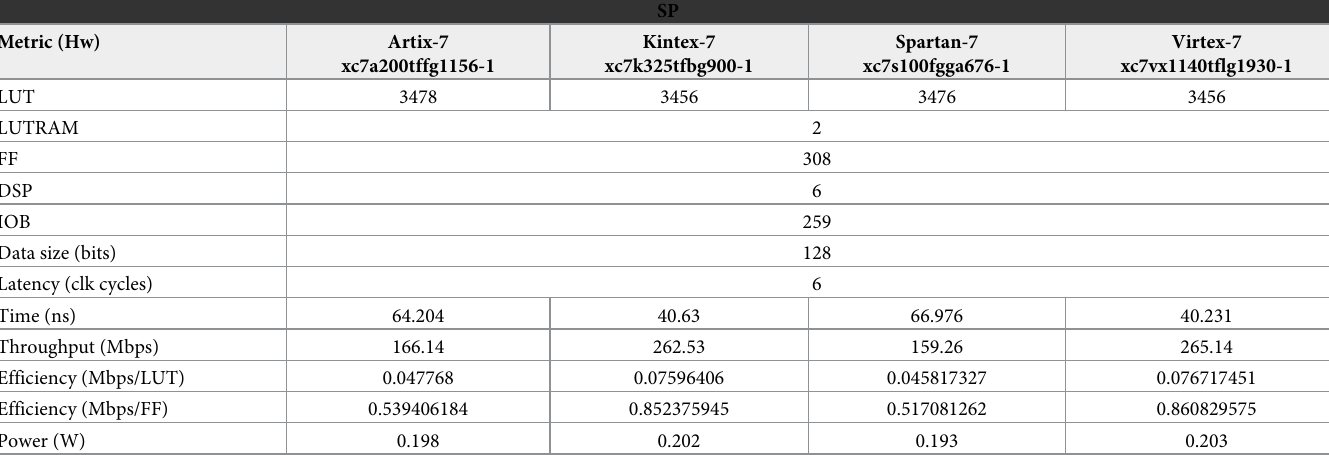
Table 6. Implementation results for the SP-based hardware architecture.